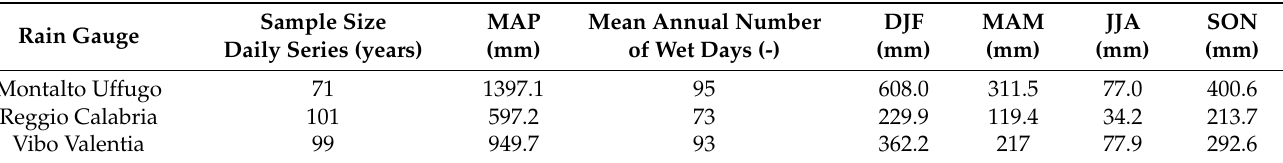
Table 3. Montalto Uffugo, Reggio Calabria and Vibo Valentia rain gauges: sample values of mean annual and seasonal precipitation, and mean annual number of wet